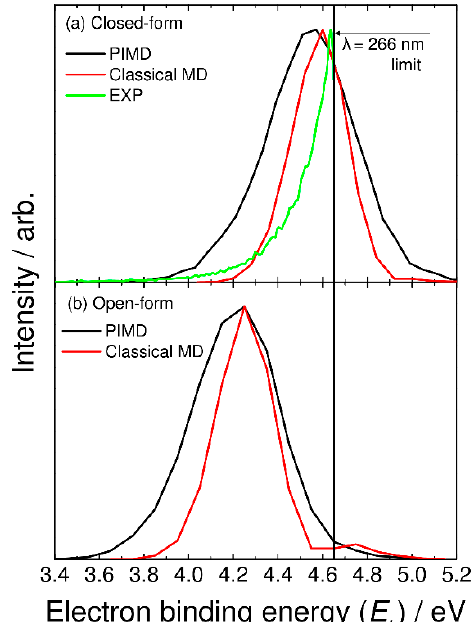
Figure 3. Photoelectron spectra for ( a ) closed-form and ( b ) open-form C 2 O 4 H − calculated using the semiclassical method based on the PIMD nuclear density (black solid lines). In panel ( a ), the photoelectron spectrum calculated with the classical MD method is shown by the red solid line, and the experimental photoelectron spectrum measured at λ = 266 nm (taken from Ref. [5]) is also shown by the green solid